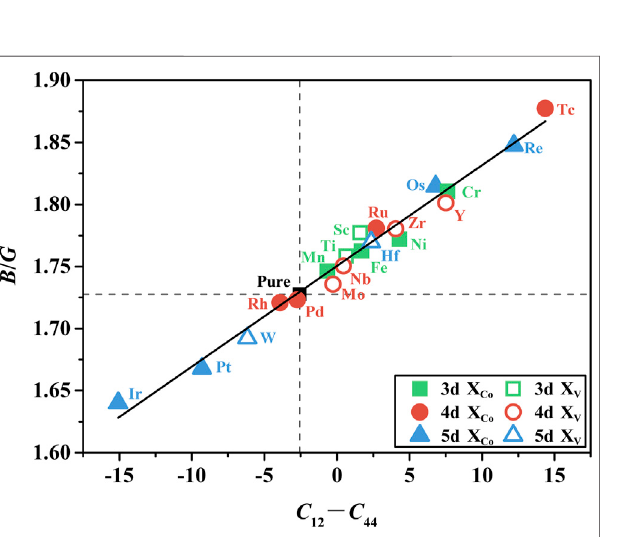
Frontiers in Materials |